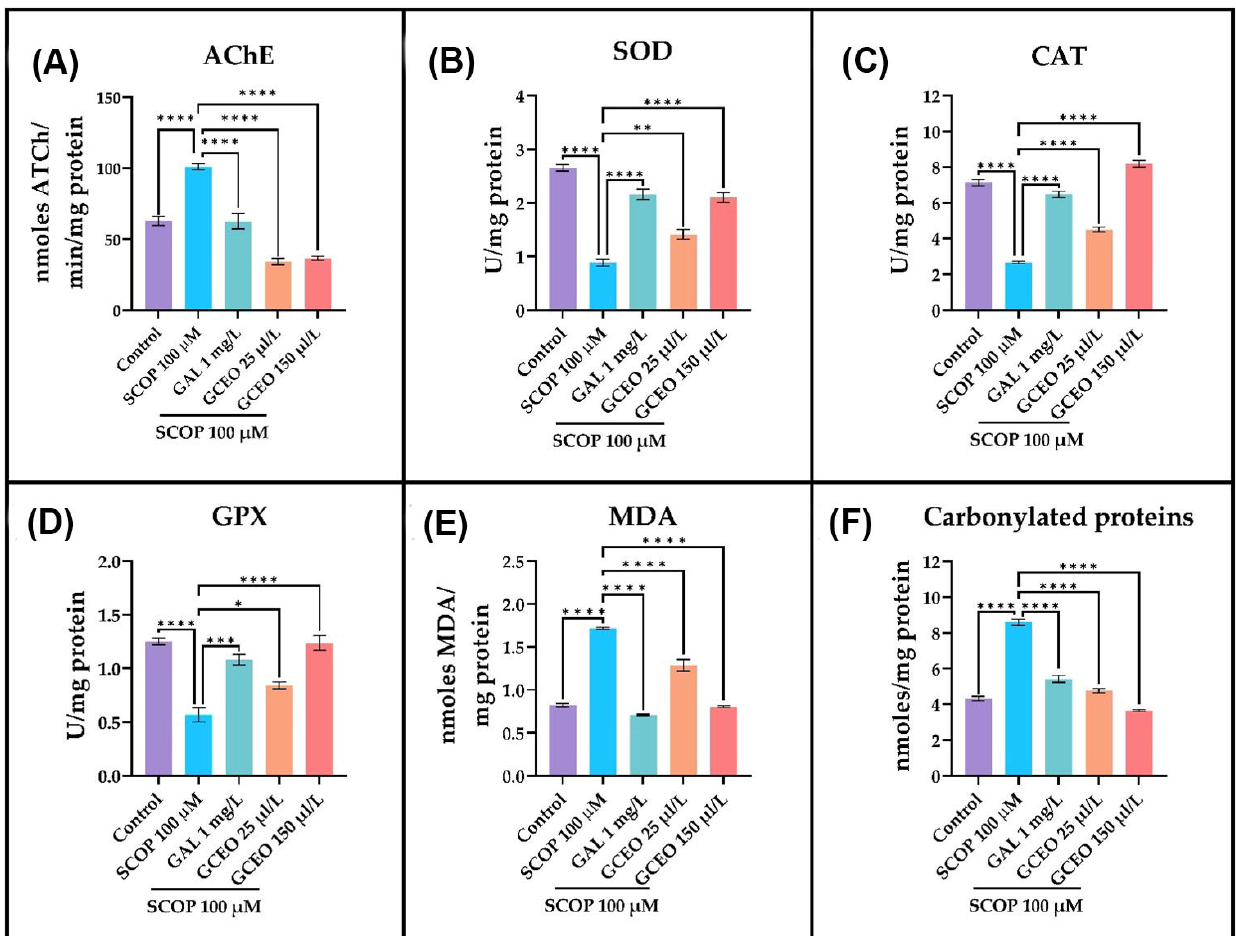
Figure 5. The effects of Glaucosciadium cordifolium essential oil (GCEO, 25 and 150 µL/L) on the specific activities of ( A ) AChE, ( B ) SOD, ( C ) CAT and ( D ) GPX and on the content of ( E ) MDA and ( F ) carbonylated proteins. The values are expressed as means ± S.E.M. ( n = 3). One-way ANOVA revealed overall significant differences between groups in ( A ) F(4,10) = 71.34, p < 0.0001, ( B ) F(4,10) = 72.67, p < 0.0001, ( C ) F(4,10) = 198.1, p < 0.0001, ( D ) F(4,10) = 30.99, p < 0.0001, ( E ) F(4,10) = 177.8, p < 0.0001 and ( F ) F(4,10) = 185.4, p < 0.0001. For Tukey’s post hoc analyses, **** p < 0.0001, *** p < 0.001, ** p < 0.01 and * p < 0.05.